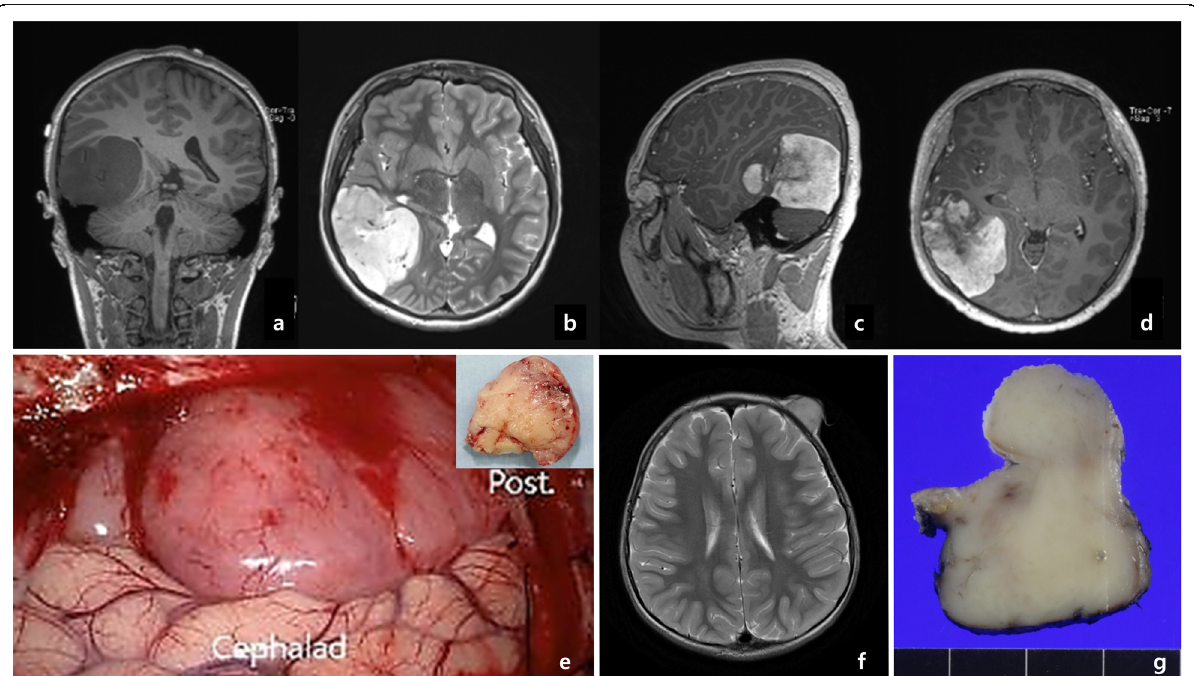
Fig. 1 a - e Case 1 with TPR - NTRK1 fusion.: MRI reveals a ) T1-low, b-d ) T2-high dura-based mass with enhancement. e The tumor was located in the right temporal convexity and right cerebellar tent (The direction of the brain mentioned as cephalhead and posterior). The inlet is the cut surface of the tumor showing yellowish, and solid without hemorrhage or necrosis. f , g Case 2 with LMNA-NTRK1 fusion tumor: T2 weighted MRI revealed low-density mass on the left forehead. The cut surface of the tumor shows a gray-white solid appearance without hemorrhage or